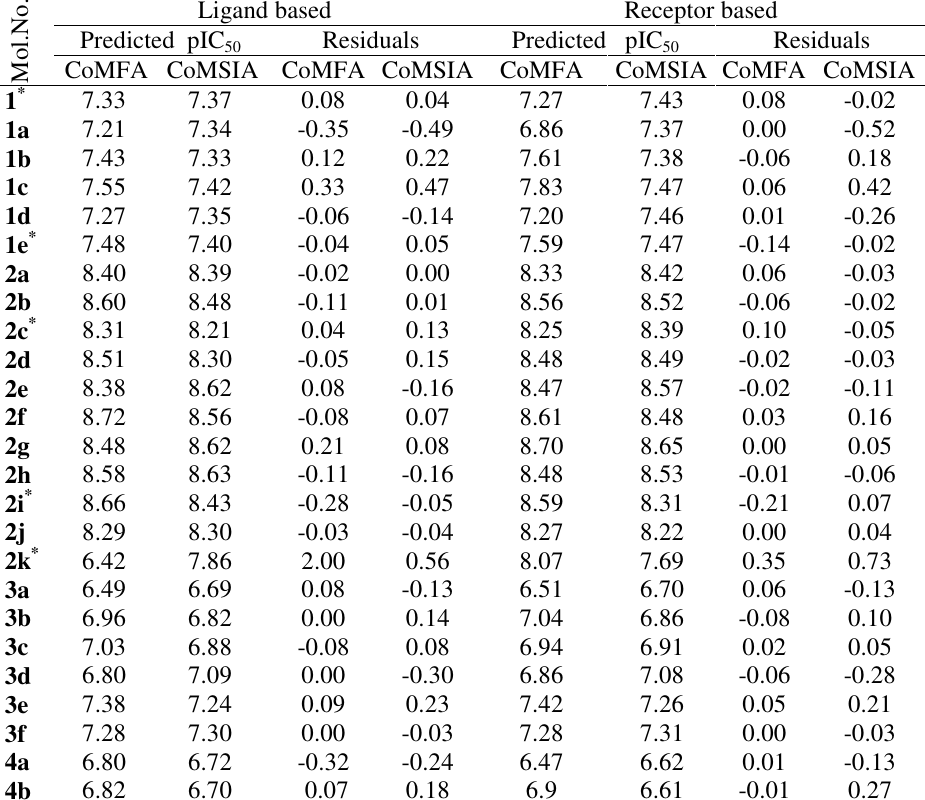
Table 3. Data set used for 3D-QSAR analysis with corresponding actual and predicted